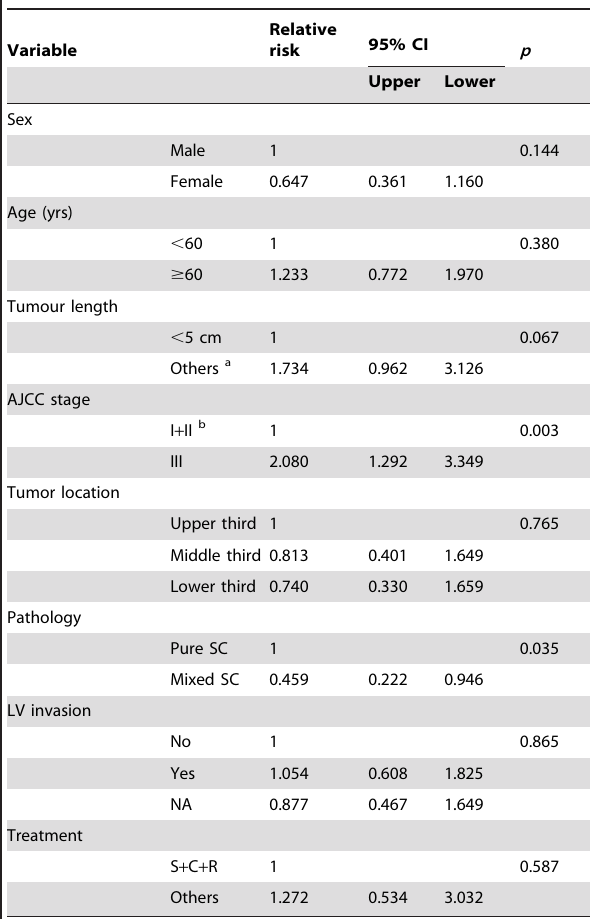
Table 4. Factors that affect the overall survival by multivariate Cox regression analysis for the entire cohort of patients (n